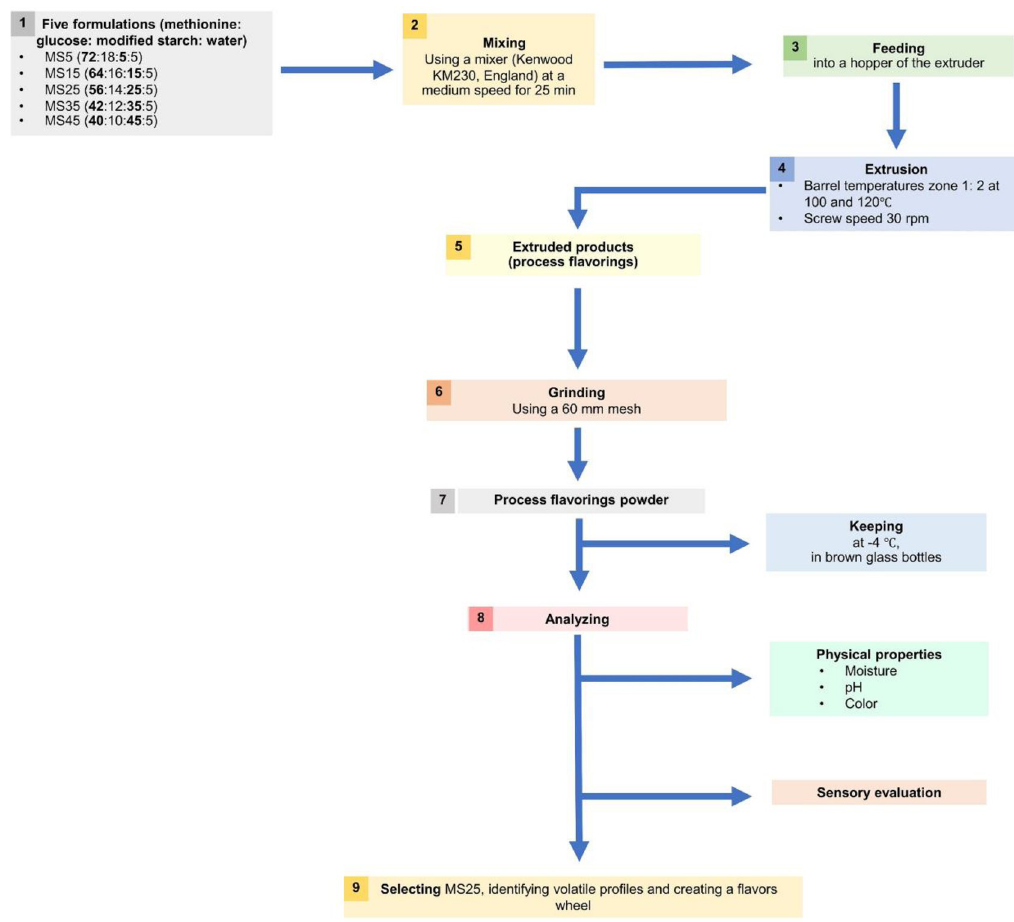
Fig 1. Overall experiments for the study of process flavorings production by extrusion using modified starch as a